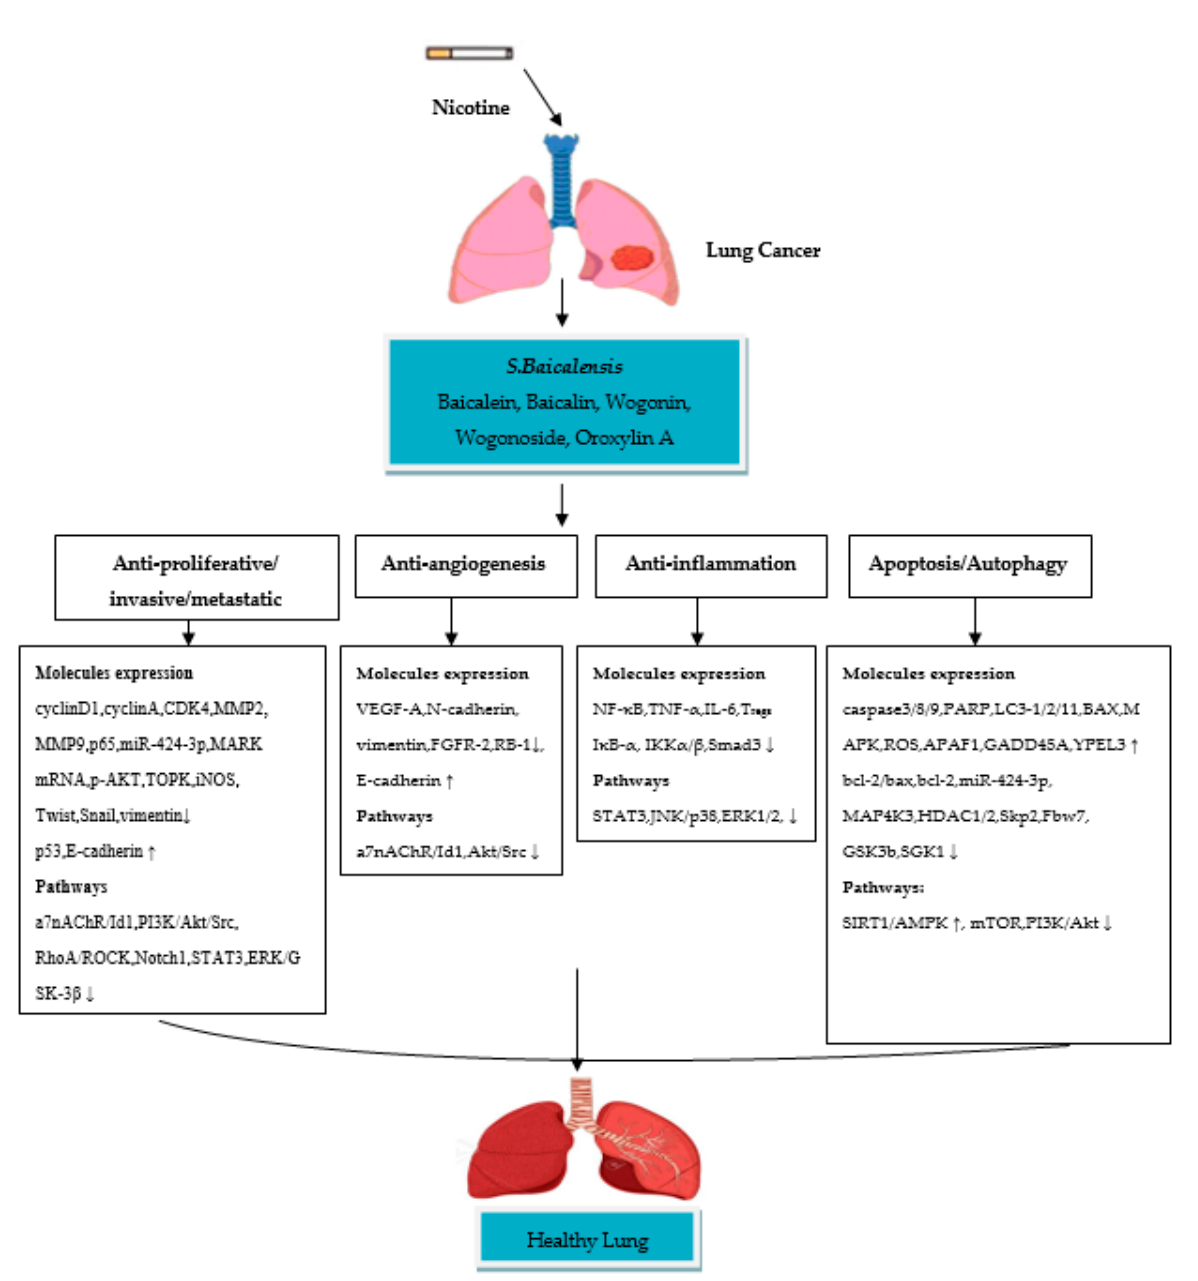
Figure 1. Schematic diagram of the molecular mechanisms of S. baicalensis compounds in nicotine-induced NSCLC treatment. ( ↓ ) decrease, ( ↑ ) increase.